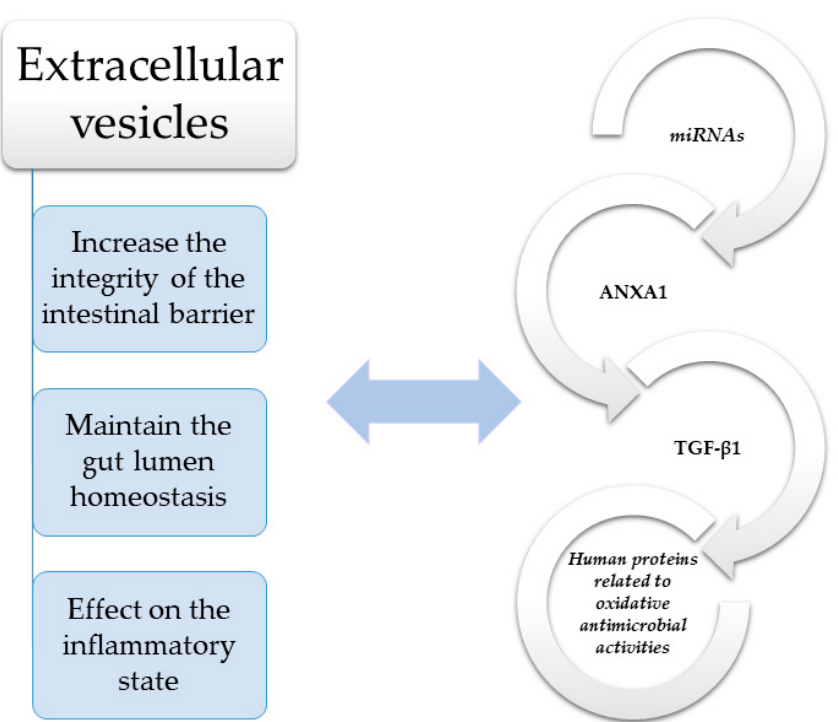
Figure 1. Molecules such as transforming growth factor β 1 (TGF- β 1) and annexin-1 (ANXA1) have a significant impact on maintaining the integrity of the intestinal barrier in IBD [60,61]. TGF- β — Transforming growth factor β ; ANXA1—Annexin-1; miRNAs—MicroRNAs. Table 1. Extracellular (EVs) vesicles in the pathogenesis of IBD.